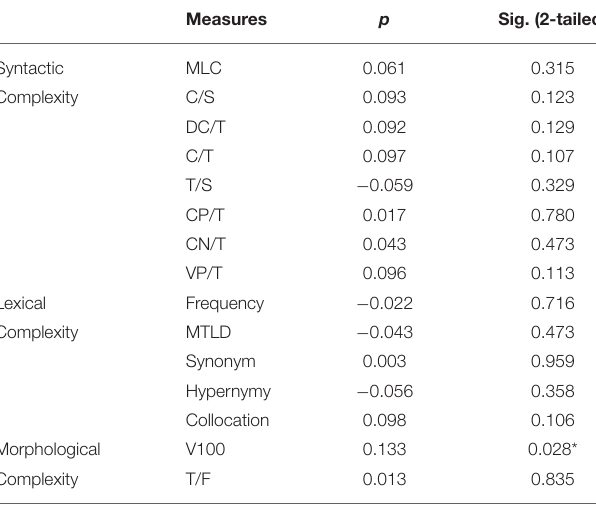
TABLE 3 | Summary of the 15 selected measures and tools of calculation. TABLE 4 | Correlations of 15 complexity measures with human-assigned score level.